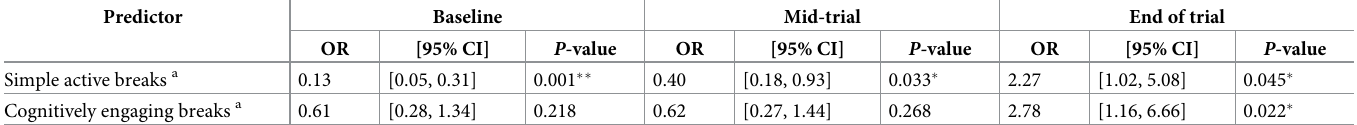
Table 6. Results from generalized linear mixed models clustered at the individual level, conducted to investigate the group differences in the odds ratios of being observed on-task during two consecutive in-class observations at each time point. Predictor Simple active breaks